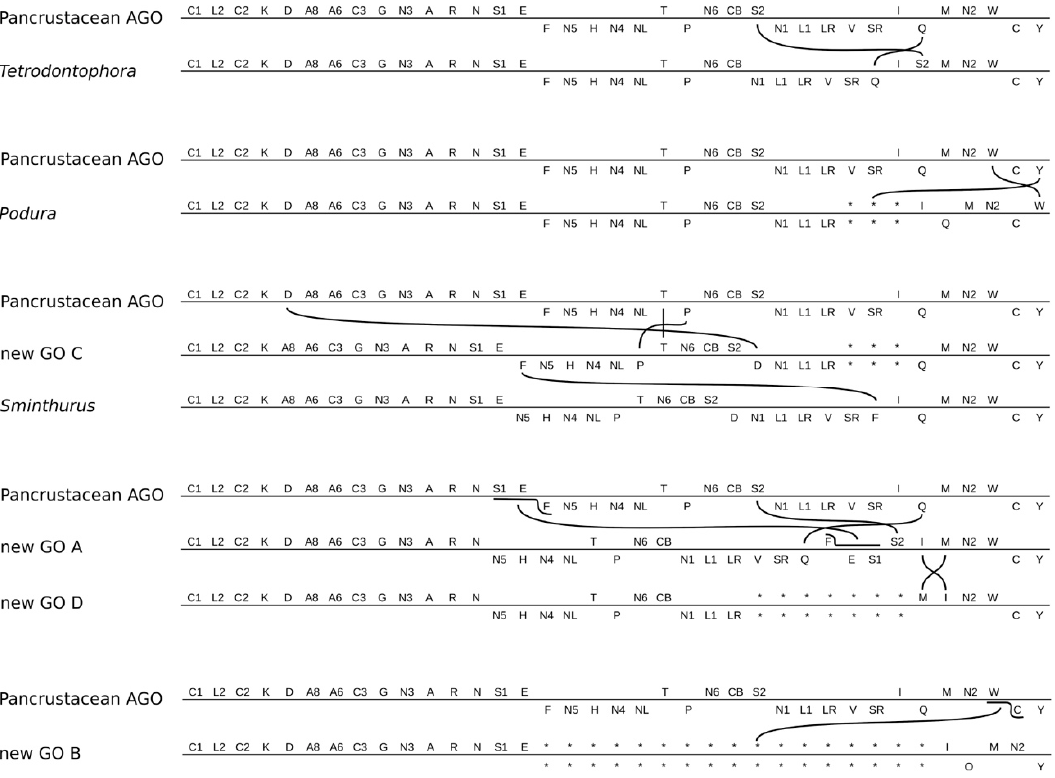
Figure 3. Comparison between the ancestral gene order (AGO) and variant gene orders described. * indicates missing sequence information.